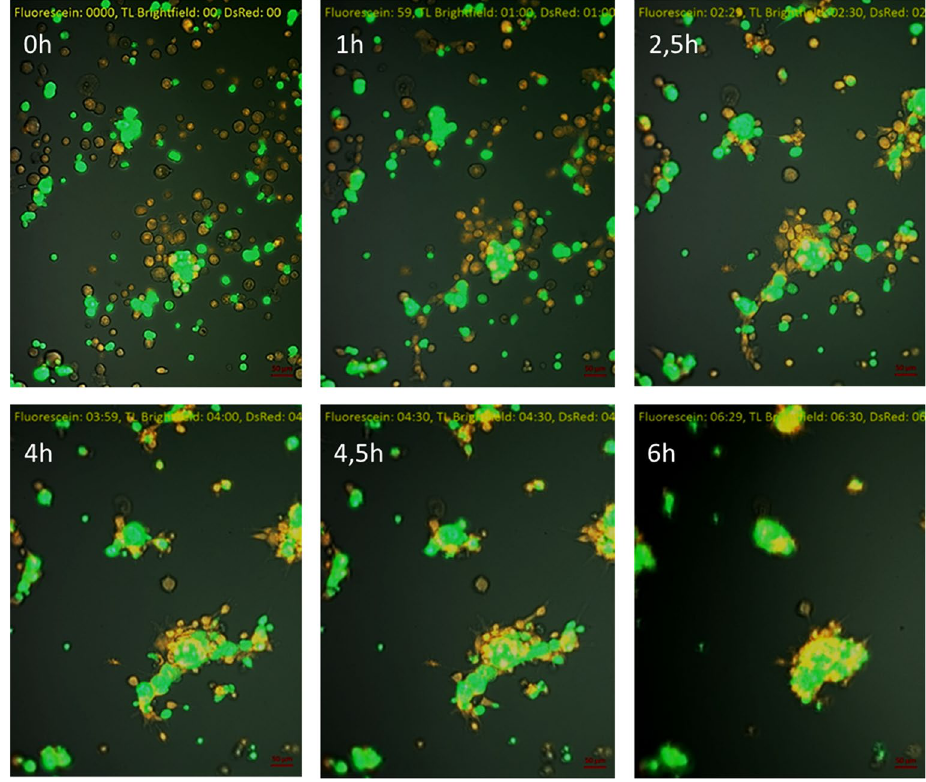
Figure 4. Tropism of MSC (red, PKH) towards GL261eGFP glioma cells (green) in Matrigel. Selected pictures show cells at the beginning of the experiment, after 1 h, after 2.5 h, after 4 h, after 4.5 h, after 6 h. After 2.5 h, tropism of MSC towards glioblastoma cells was observed, after 6 h all MSC visible in the field of view localized near cancer cells (lens magn. × 10).